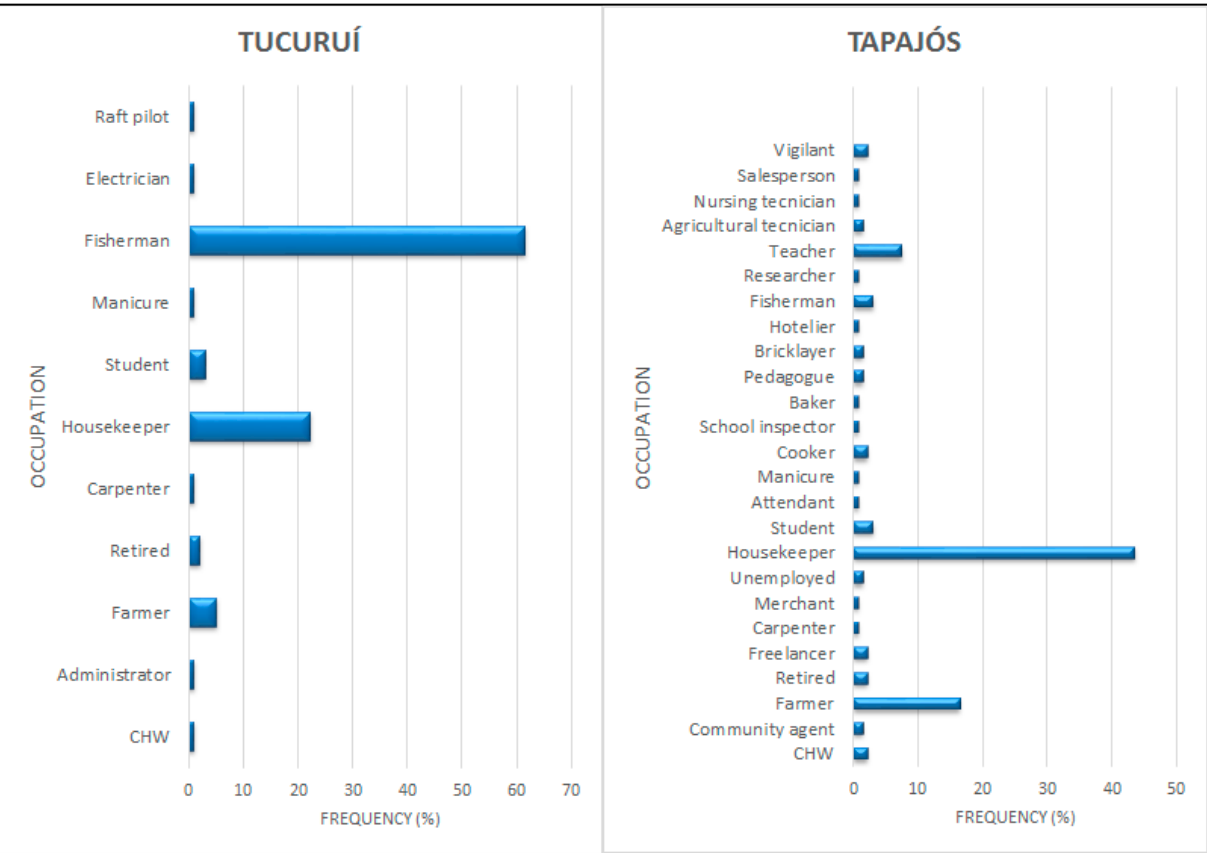
Figure 2. Occupations reported by the participants from the two Amazonian populations (Tapajós and Tucuruí). CHW = community health worker.